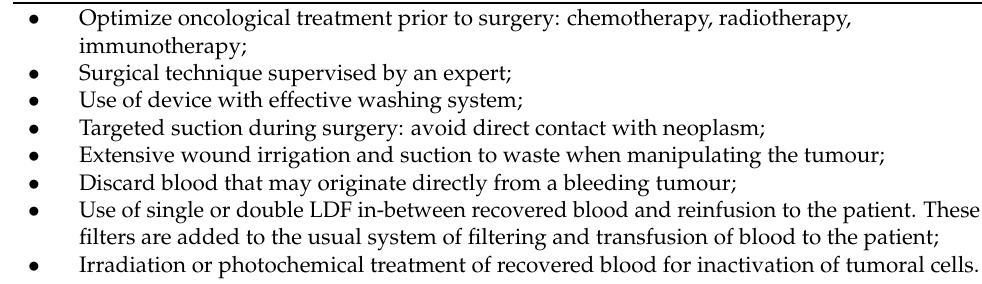
Table 2. Techniques to Reduce Tumor Load with Metastatic Potential by Using ICS